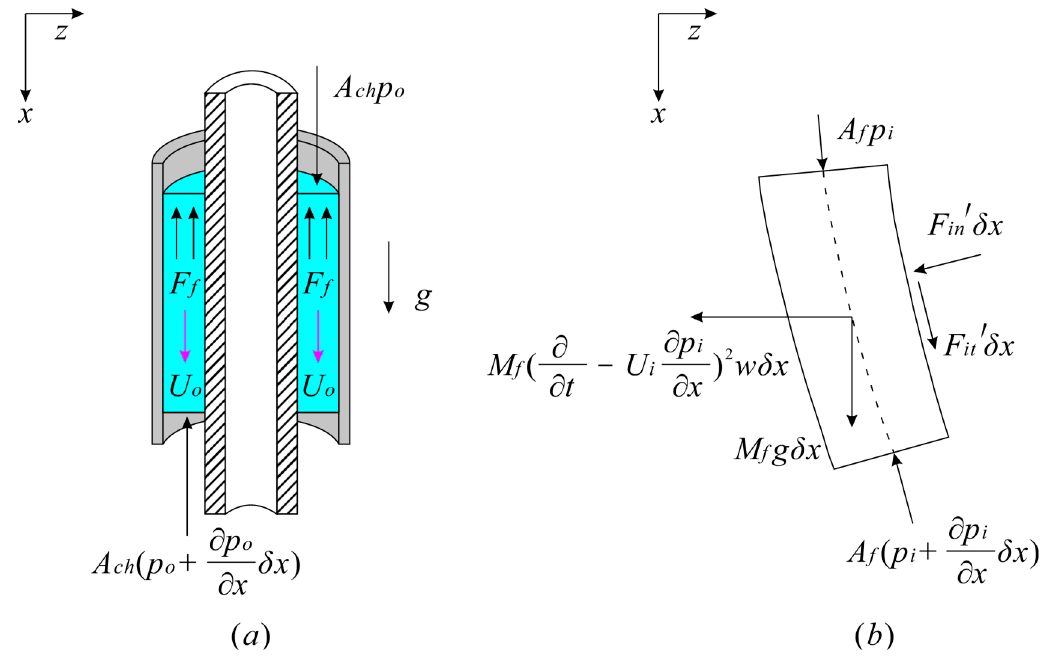
Figure 5. ( a ) Forces acting on an element of length δ x of the annular flow. ( b ) Forces acting on an element δ x of the internal fl ow.